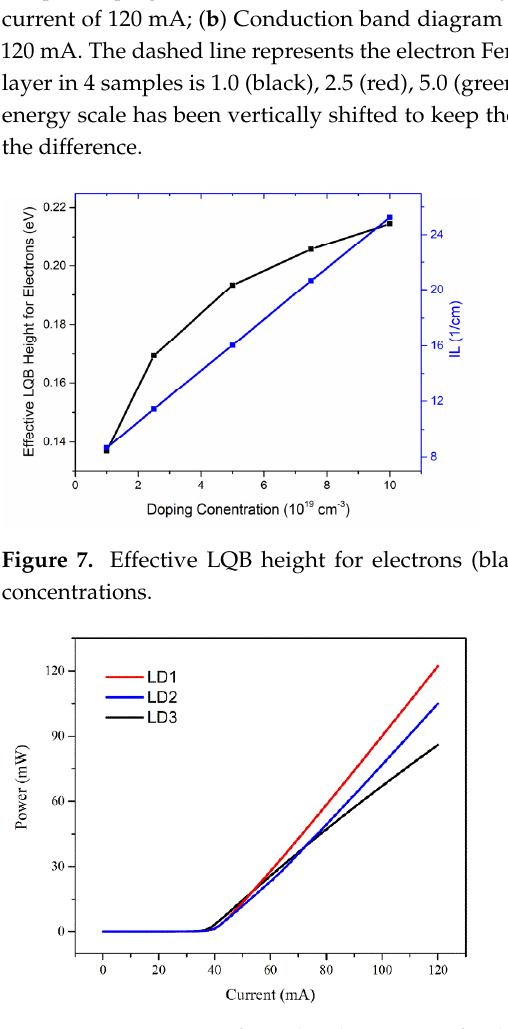
Figure 8. Comparison of simulated P–I curves for three LDs: LD1 with p-AlGaN/u-GaN CLQB (red); LD2 with p-GaN/u-GaN CLQB (blue); LD3 with u-GaN LQB (black).